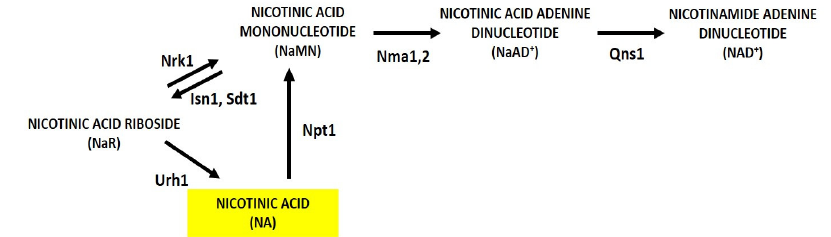
Figure 3. Scheme of NaR metabolism in yeast. NaR can be utilized for NAD + synthesis through two salvage routes that rely on Nrk1 and Urh1 and produce NaMN and NA respectively. NaR is generated intracellularly from NaMN by Isn1 and Sdt1. Abbreviations of enzyme names are reported.